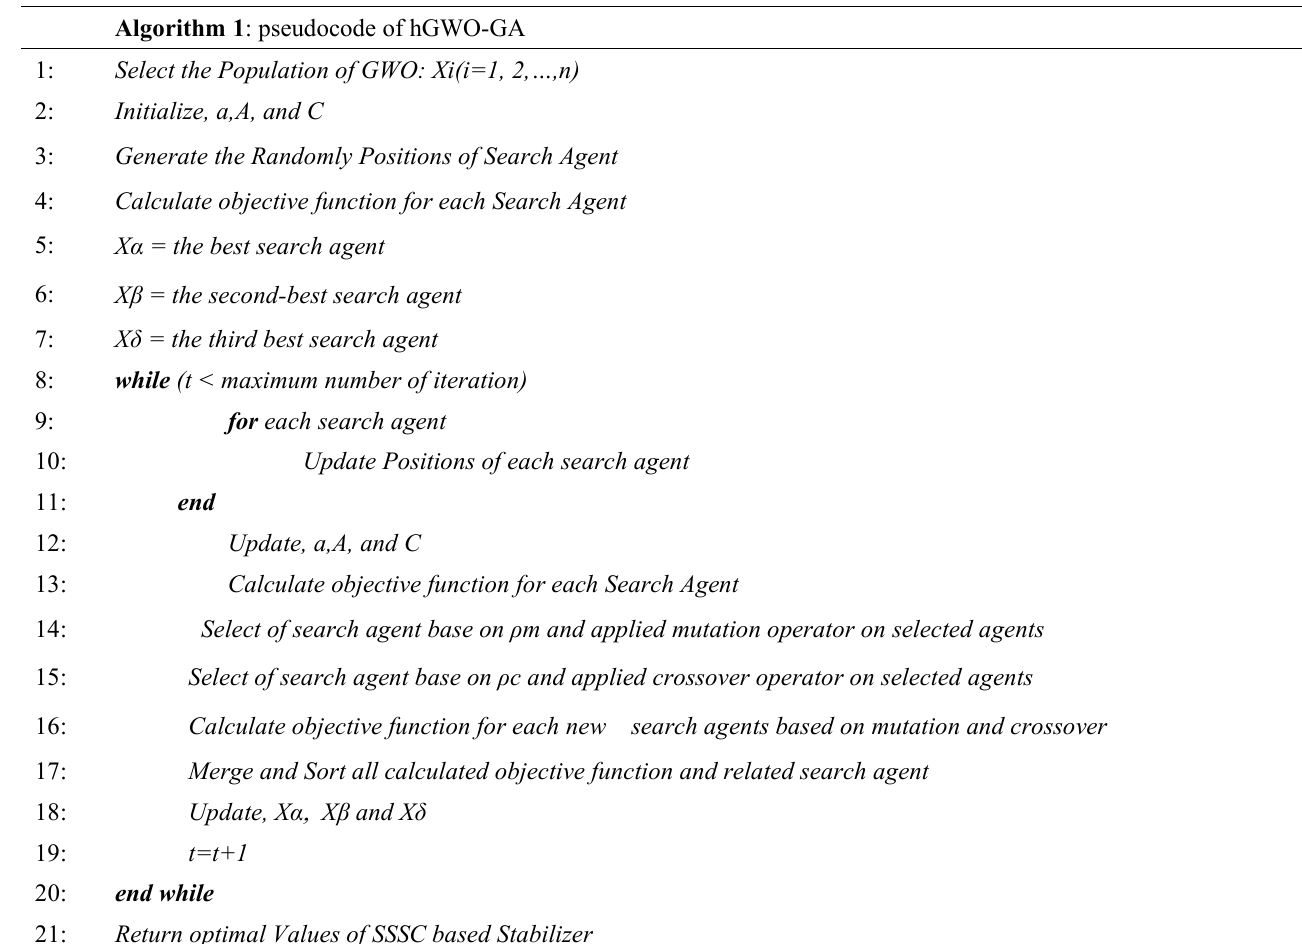
Figure 8. Pseudocode of the hGWO-GA